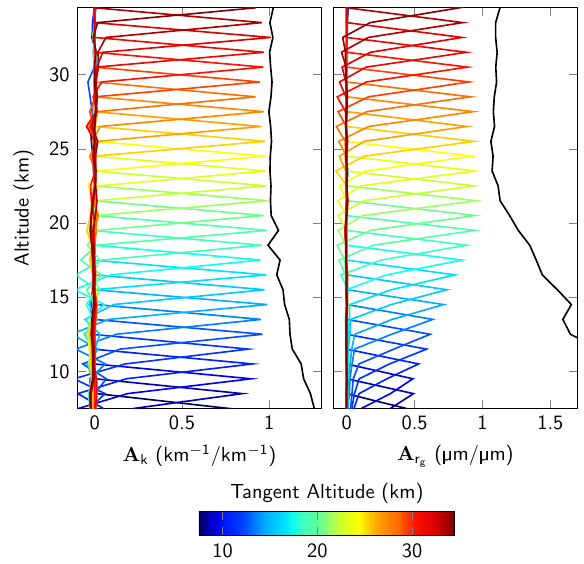
Standard Deviation Fig. 7. Error in the retrieved parameters under a variety of simulated measurement conditions when the true atmospheric state is bimodal. Error using the coupled extinction and mode radius retrieval are shown in black with dashed lines showing the standard deviation.